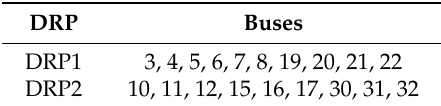
Table 2. Supported areas of Demand Response Providers (DRPs) in the distribution system.